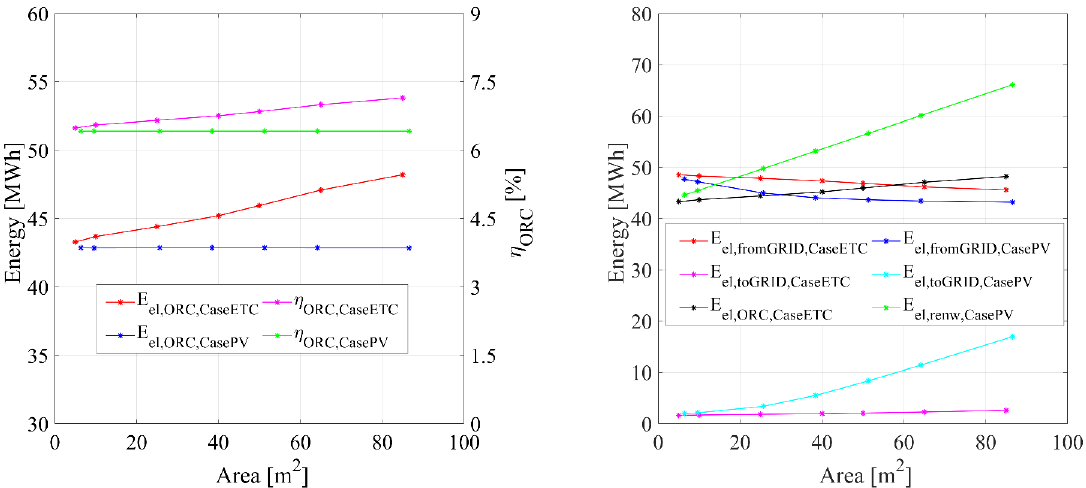
Figure 12. Parametric analysis: ORC performance ( left ) and electric energy performance ( right ).